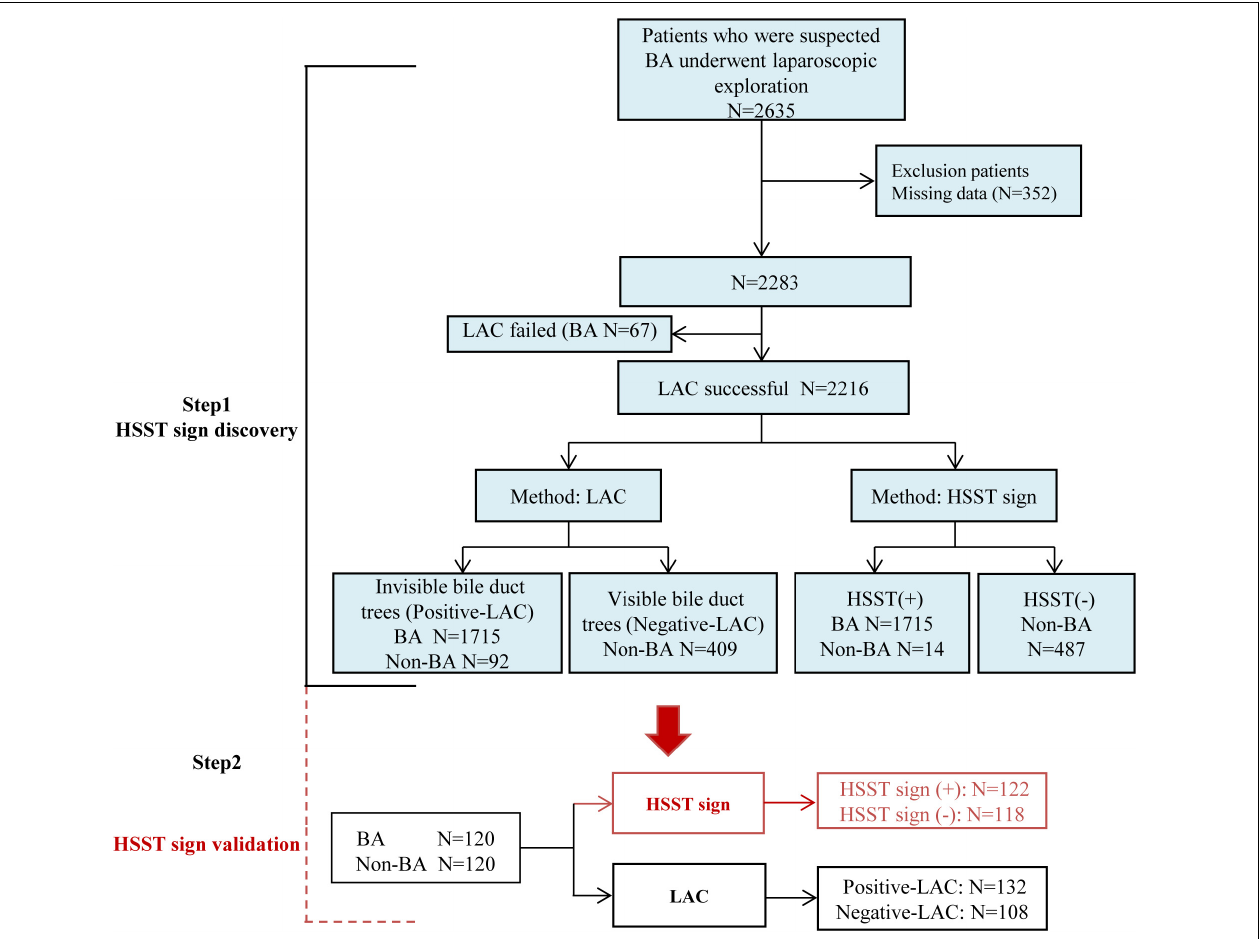
FIGURE 1 | Study design. HSST: hepatic subcapsular spider-like telangiectasis; LAC: laparoscopy-assisted cholangiography; BA: biliary atresia; LAC failed: patients cannot undergo cholangiography due to atrophic gallbladders; Positive LAC: the intrahepatic bile ducts cannot be visualized; Negative LAC: the intrahepatic bile ducts can be